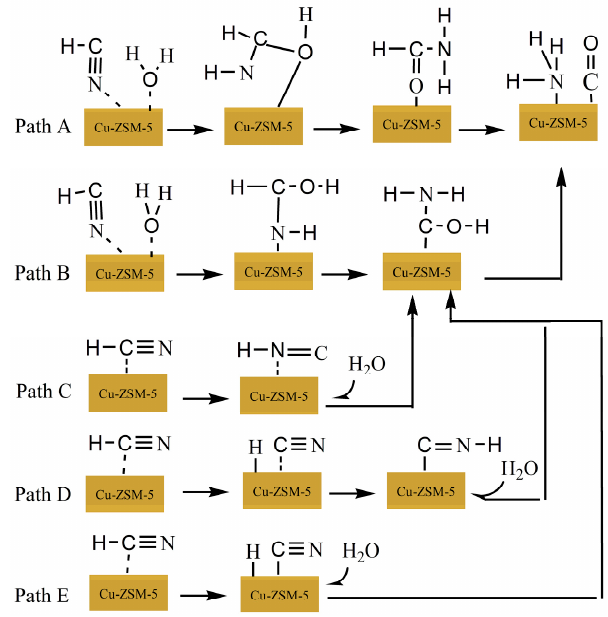
Figure 3. The scheme of five reaction paths .